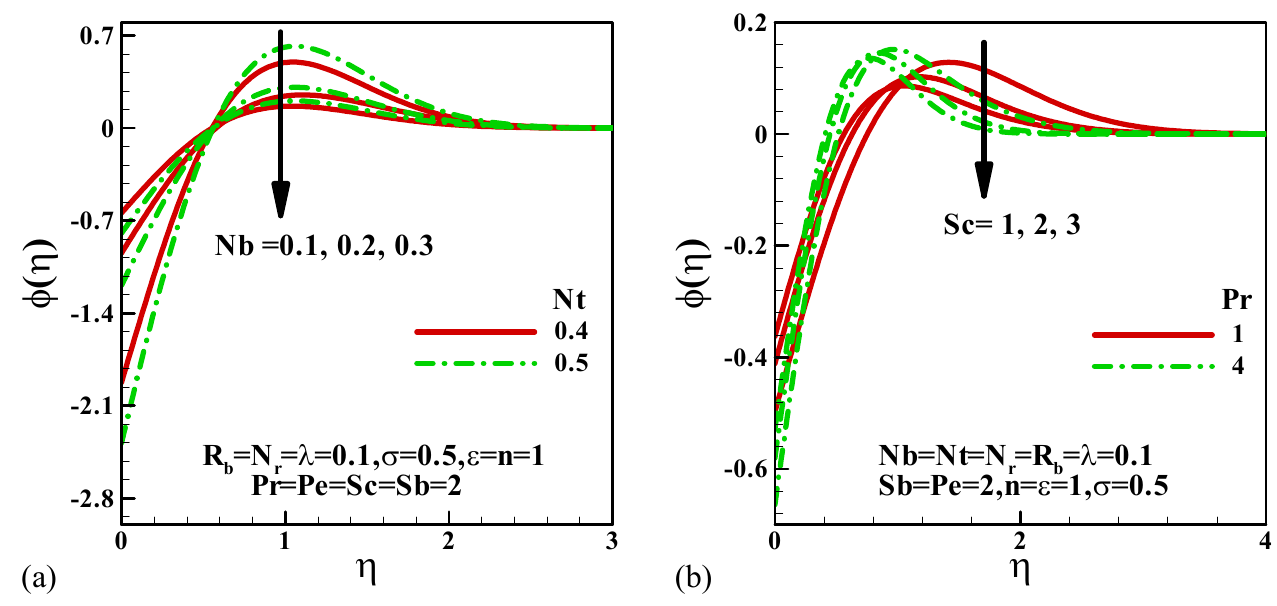
Figure 5. Variation in the dimensionless nanofluid concentration with ( a ) nanofluid parameters and ( b ) Schmidt number for different fluids.